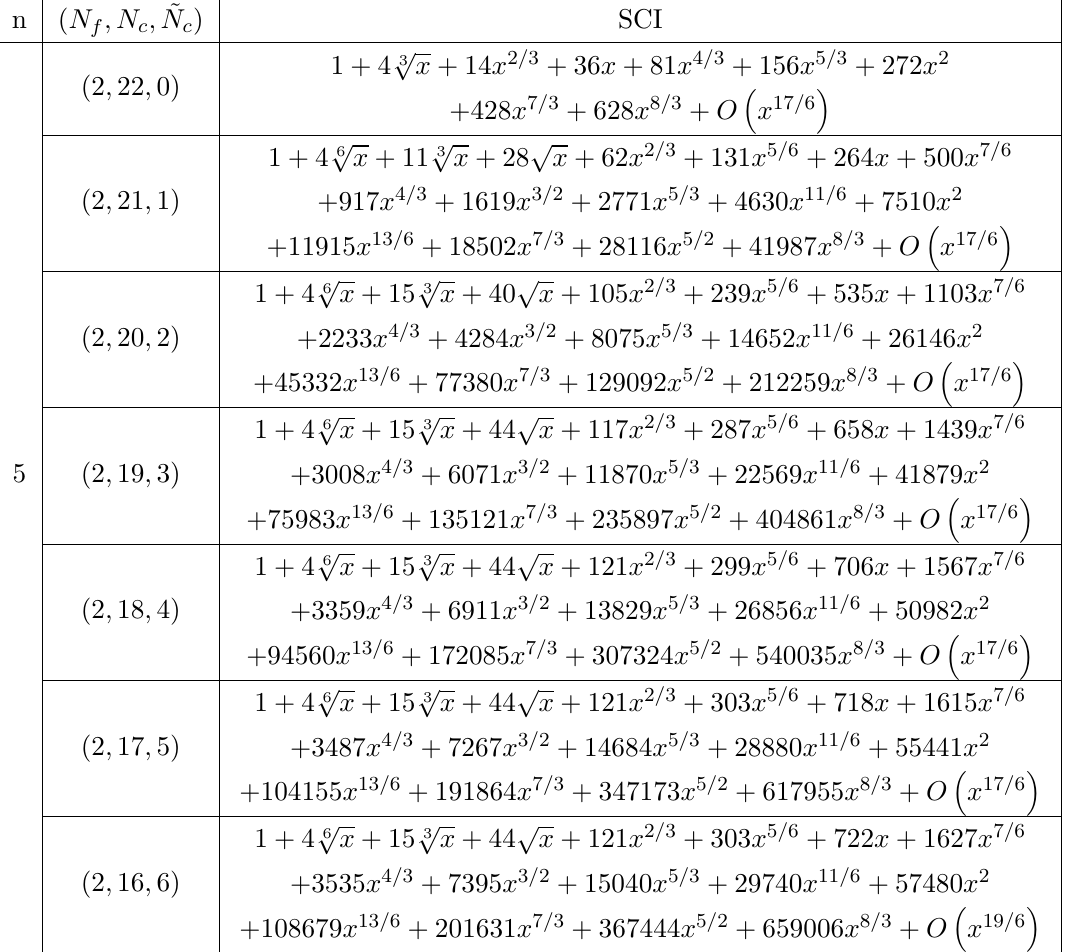
) = (5 , 2) , whereas the other results with ( n, N f